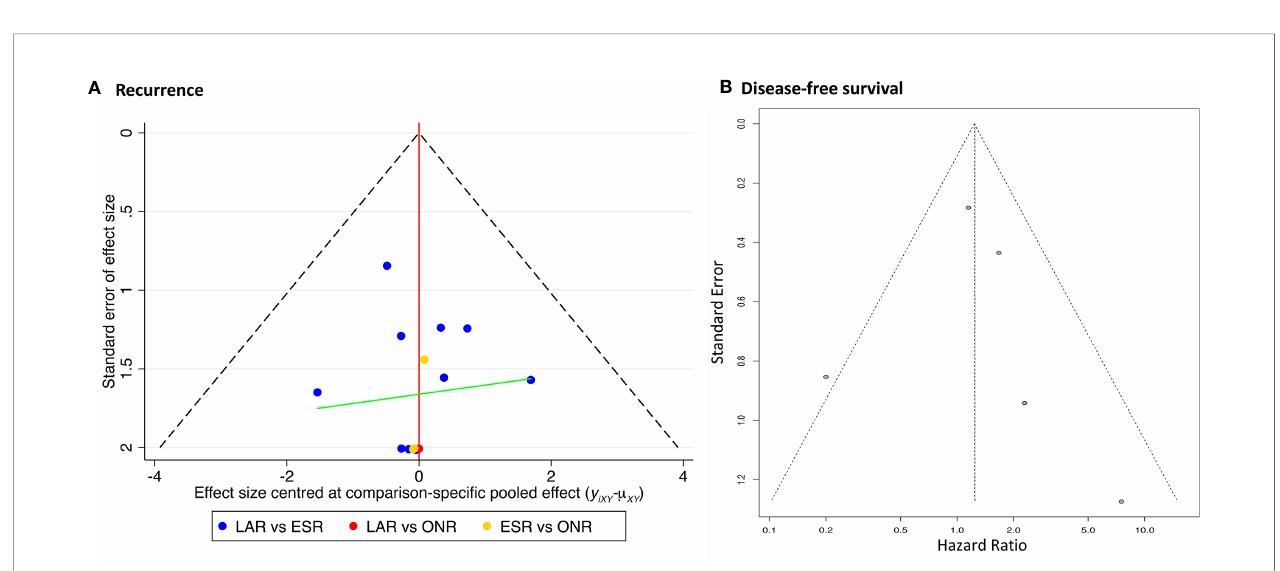
FIGURE 8 | Publication bias of (A) recurrence rate and (B) disease-free